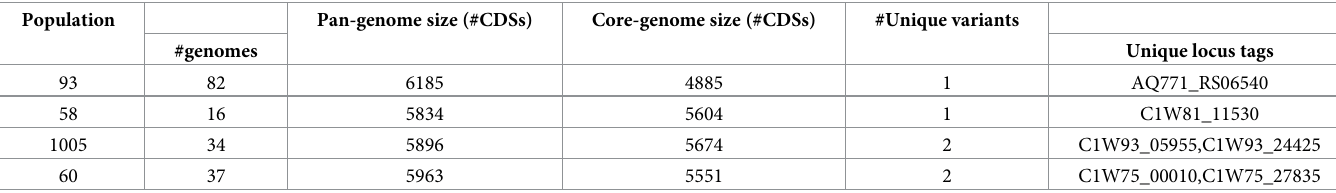
Table 1. Coding region stats for each major INT2 sequence